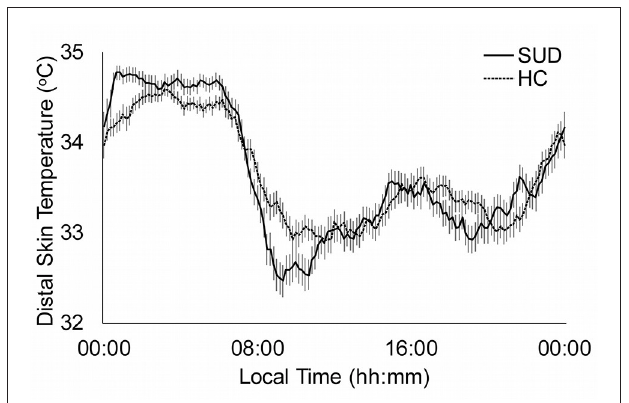
FIGURE 1 | Distal skin temperature mean daily patterns for substance use disorder patients (SUD; continuous line, n: 114) and healthy controls (HC; dotted line, n = 103). All data are expressed as mean ± standard error of the mean.